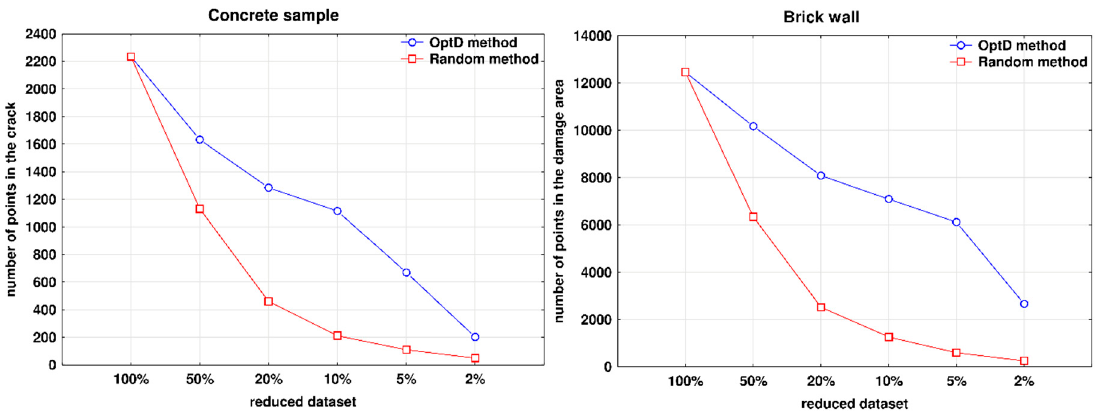
Figure 9. Reduction of points on the crack and cavities using the OptD method and the random method.